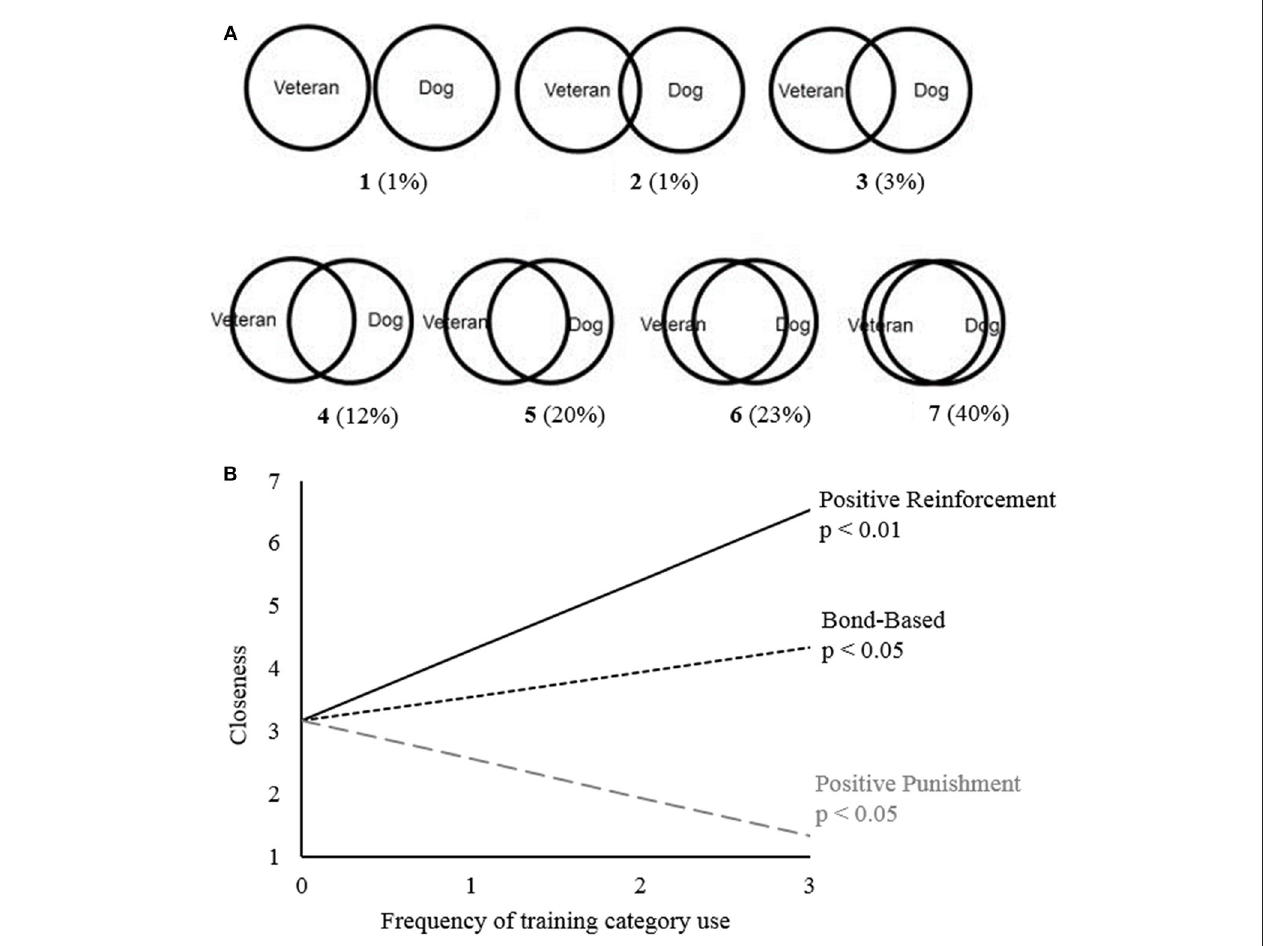
FIGURE 1 | Closeness and Training Methods. Military veterans ( N = 111) were asked to describe the current relationship between themselves and their service dog (self-perceived closeness) by choosing an item on a pictorial scale. (A) The pictorial scale shown to military veterans, replicated from the Inclusion of Others in the Self Scale. In parentheses is the overall percentage of military veterans who chose each picture in this sample. (B) Significant associations between reported closeness and training methods resulting from linear regression models. Training Methods Scale: 0 = Never, 1 = Once, 2 = Once a Week, 3 =